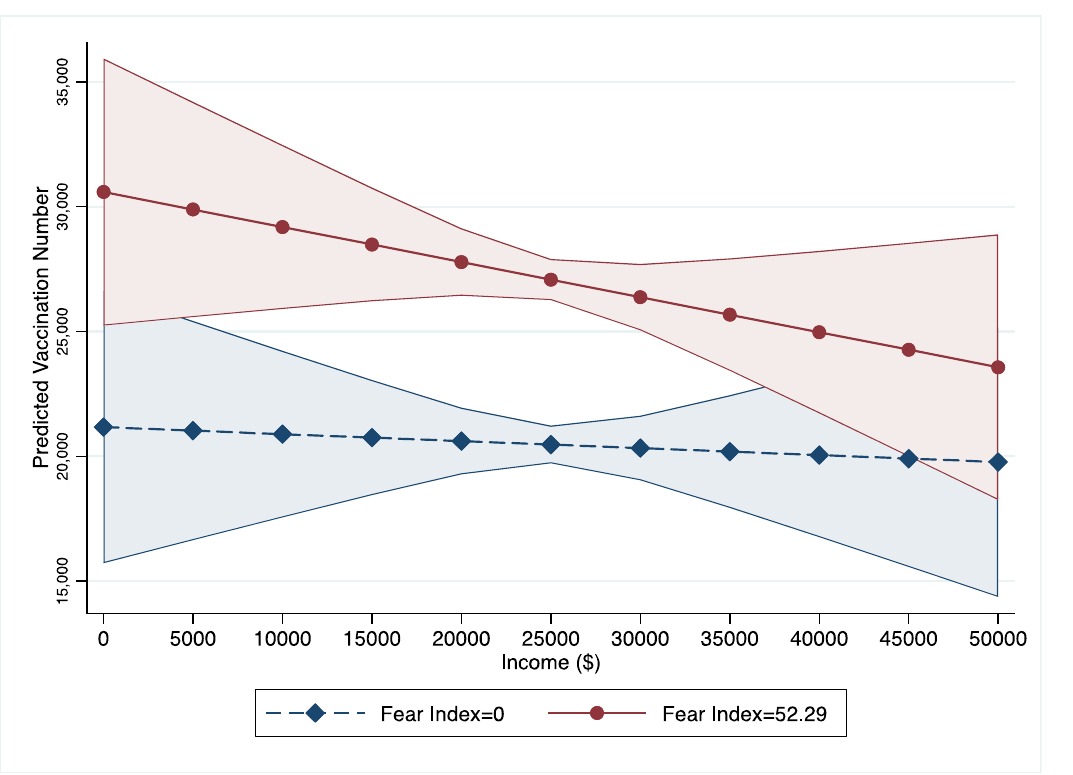
Figure 1. Interaction Effects between PFC and Income. Note: PFC value of 52.29 is the 95% interval and represents county-level communities with a high fear level.